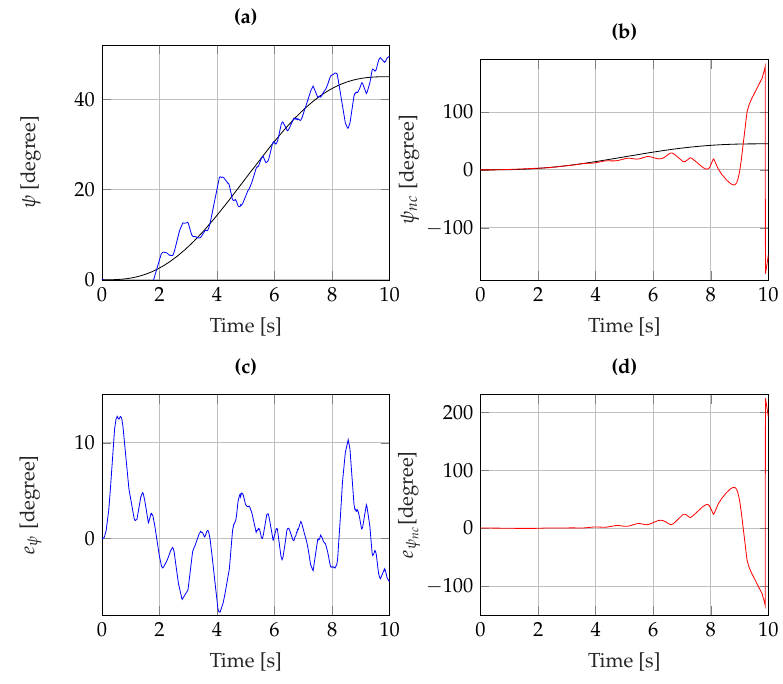
Figure 8. (a) UAV yaw angle: the reference ψ ref (black), ψ with robust control (blue); (b) UAV yaw Figure 8. ( a ) UAV yaw angle: the reference ψ ref (black), ψ with robust control (blue); ( b ) UAV yaw angle: the reference ψ ref (black), ψ nc with non robust control (red); (c) yaw angle error of the UAV angle: the reference ψ ref (black), ψ nc with non-robust control (red); ( c ) yaw angle error of the UAV with robust control e ψ (blue); (d) yaw angle error of the UAV with non robust control e ψ with robust control e ψ (blue); ( d ) yaw angle error of the UAV with non-robust control e ψ